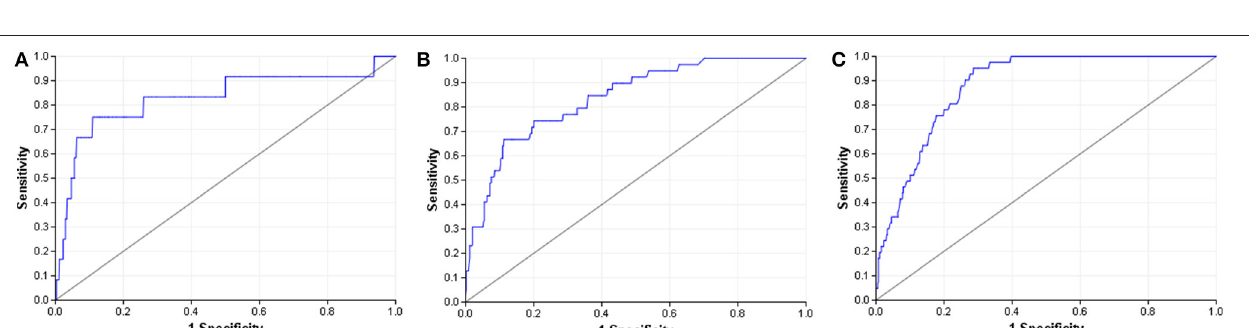
FIGURE 5 | ROC curves of the winning models. (A) NR-AR. (B) NR-Aromatase. (C) SR-P53.